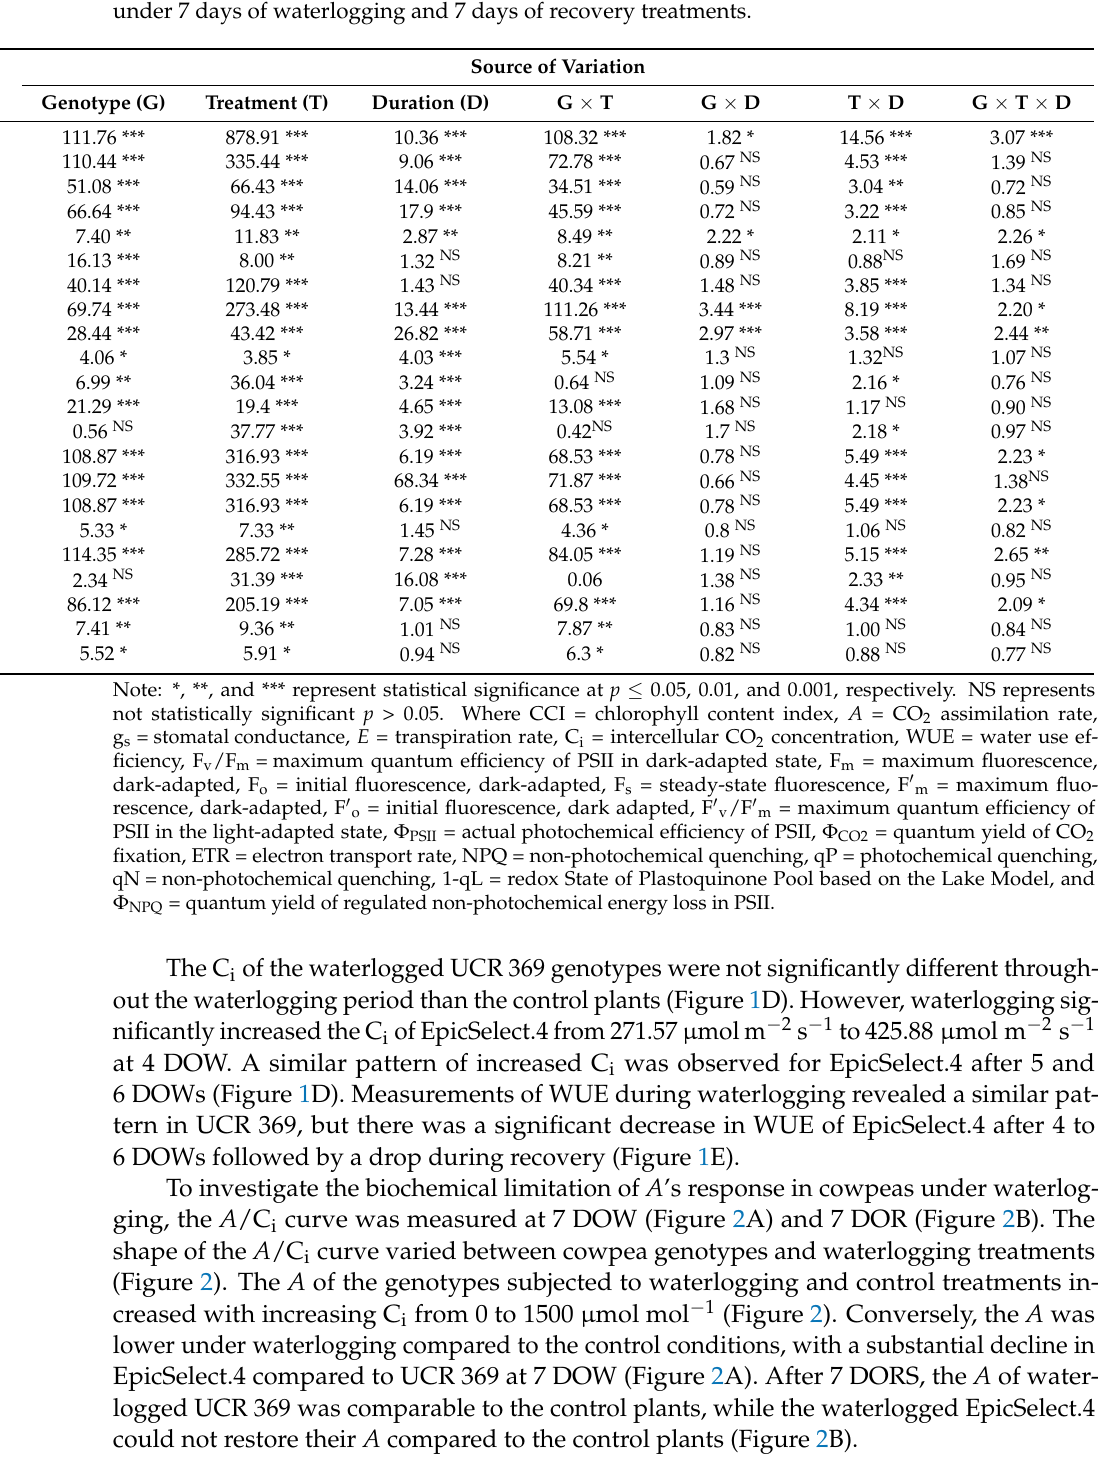
Table 2. F-values of three-way ANOVA (factors: ‘genotype, ‘treatment’, and ‘duration) for gas exchange and chlorophyll fluorescence parameters of UCR 369 and EpicSelect.4 cowpea genotypes under 7 days of waterlogging and 7 days of recovery